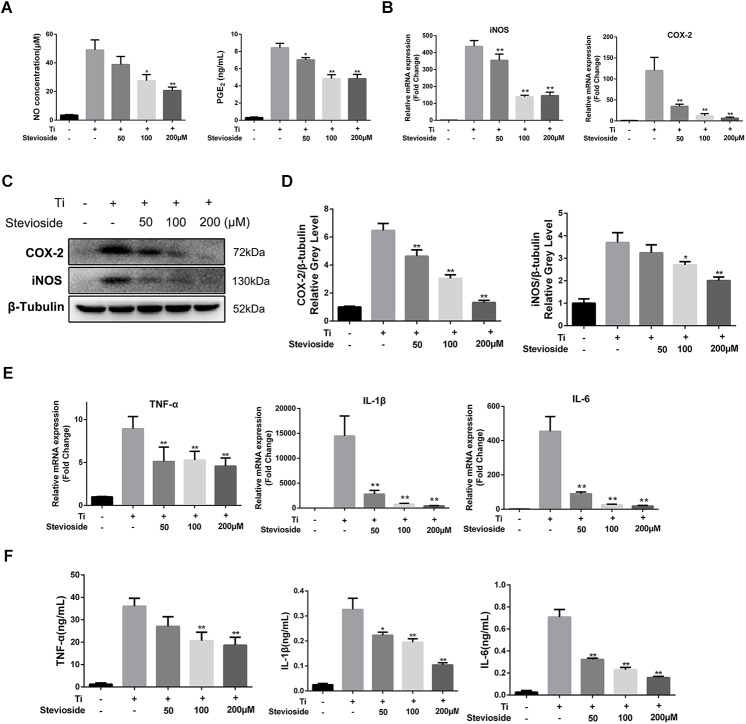
Stevioside inhibits Ti particle-induced inflammatory response in vitro. (A) BMMs were incubated with Ti particles and the indicated concentrations of stevioside for 24 h. Supernatant was collected, and the production of NO and PGE2 was measured. (B) BMMs were incubated with Ti particles and the indicated concentrations of stevioside for 6 h. The mRNA expression of iNOS and COX-2 was measured. (C) BMMs were incubated with Ti particles and the indicated concentrations of stevioside for 24 h. The protein levels of iNOS and COX-2 was explored using western blotting. (D) The gray levels of iNOS and COX-2 were normalized relative to β-tubulin using ImageJ. (E,F) BMMs were incubated with Ti particles and the indicated concentrations of stevioside for 6 or 24 h. The mRNA and protein levels of TNF-α, IL-1β, and IL-6 in BMMs were measured at 6 h for mRNA and 24 h for protein. Data are presented as mean ± SD. ∗P < 0.05, ∗∗P < 0.01, compared with Ti particles alone.